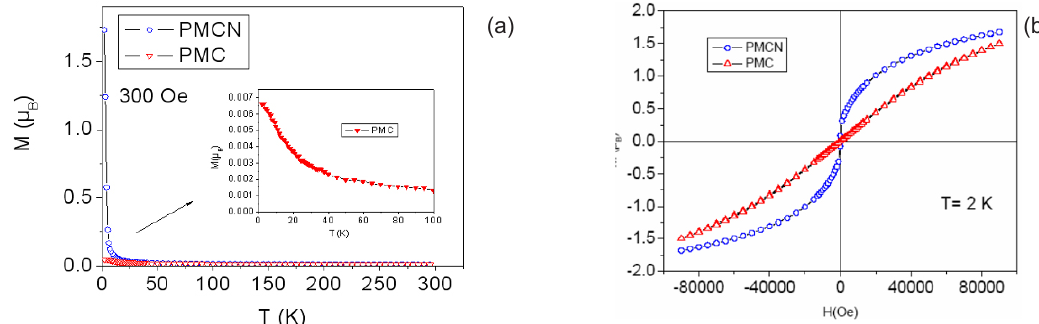
Figure 5. Comparison of (a) M(T) at 300 Oe (zoom of PMC) and (b) M(H) at 2 K of PrMg